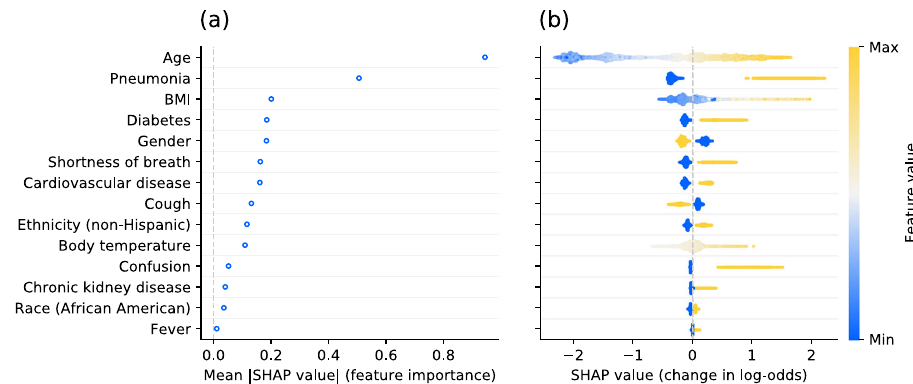
Fig. 7 Final model interpretability for the reduced feature set. a Average absolute impact of features on the fi nal model output magnitude (in log-odds) ordered by decreasing feature importance. b Illustration of the relation between feature values and impact (in terms of magnitude and direction) on prediction output. Each dot represents an individual patient of the dataset. The color of each point corresponds to the normalized feature value (min-max normalization on test set). As an example for continuous features, older patients tend to have a higher SHAP value. For binary features, the maximum feature value 1 corresponds to presence of the feature, and 0 to absence of the feature. For gender, 1 corresponds to female and 0 to